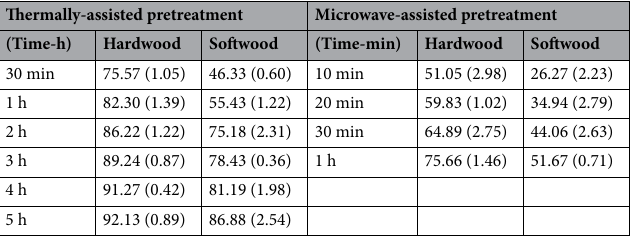
Table 2. Delignification rate (%) of untreated and pretreated biomass of hardwood and softwood. The parentheses contain the standard deviation with the analysis repeated